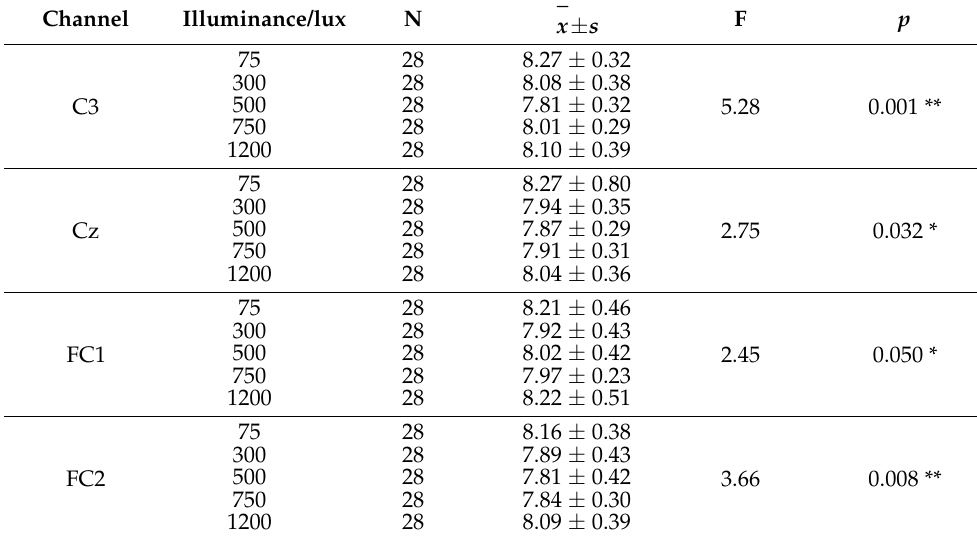
Table 8. δ -band One-Way ANOVA results.